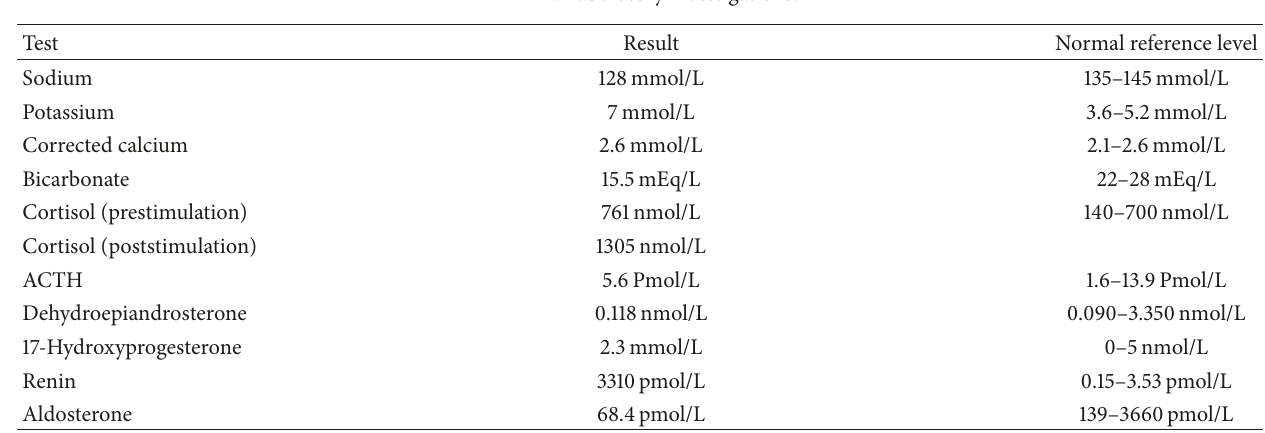
Table 2: Laboratory